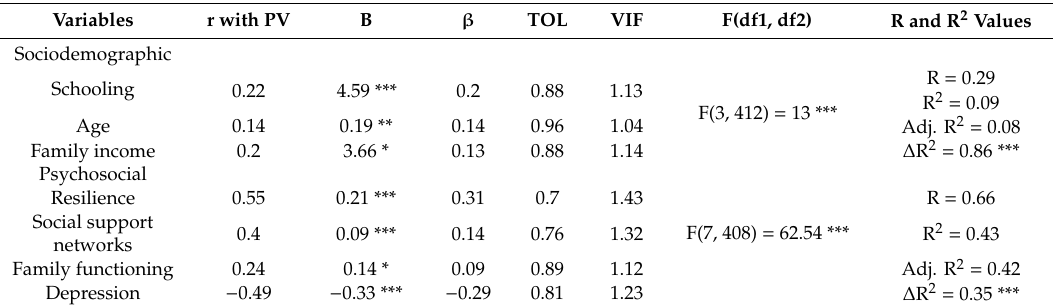
Table 4. Model of parental quality of life based on hierarchical